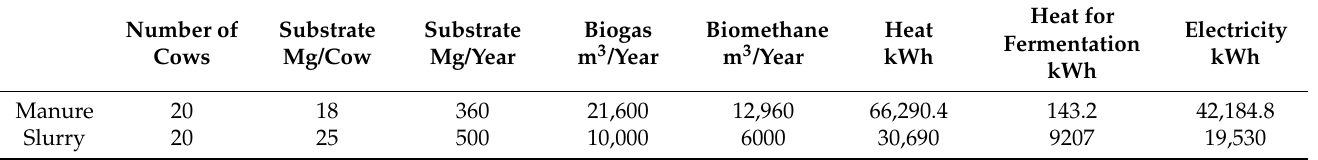
Table 1. Energy products from manures for a specific number of cattle.